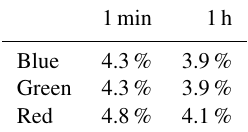
Figure 6. Standard deviation of the attenuation coefficient measured on filtered air as a function of averaging time. The thick black line with solid symbols represents the measurement data based on 8h of measurements/spot; the thin black line with open symbols shows the measurement data when each spot was sampled for 1 week; the red line represents the approximate slope for 5–100s averaging time; the blue line represents the approximate slope for 2min to 1-day averaging